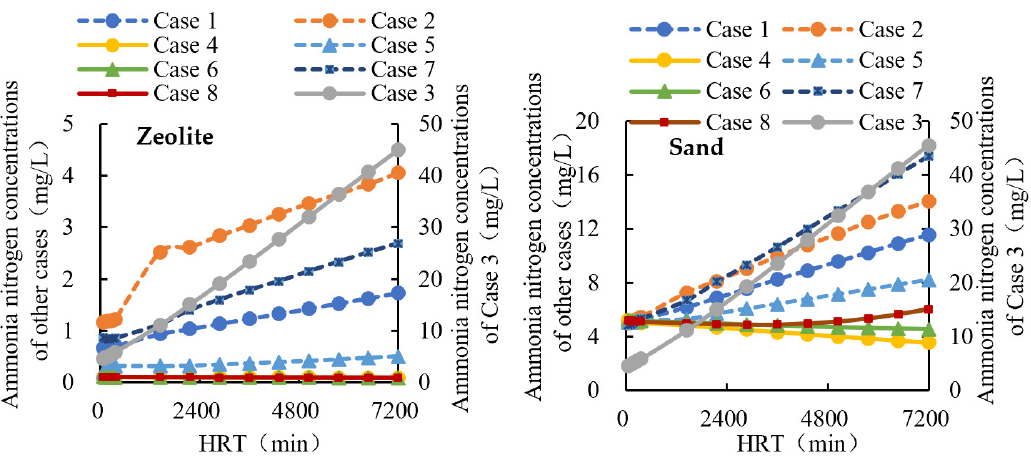
Figure 9. NH 4+ -N concentrations with different straw volume.